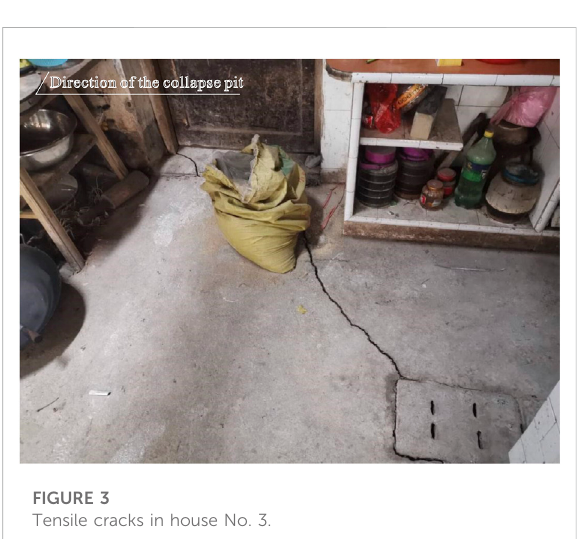
FIGURE 3 Tensile cracks in house No.